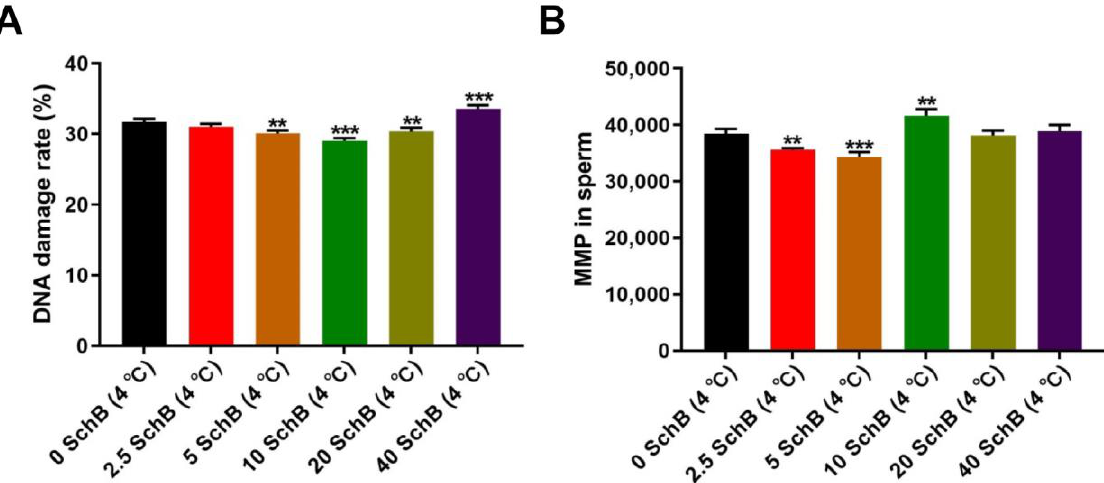
Figure 3. Effects of Sch B on the DNA damage rate and MMP changes in boar sperm: ( A ) DNA damage rate. ( B ) MMP changes in sperm. Data are expressed as mean ± SD ( n = 12). *** p < 0.001 and ** p < 0.01 vs. 0 Sch B.